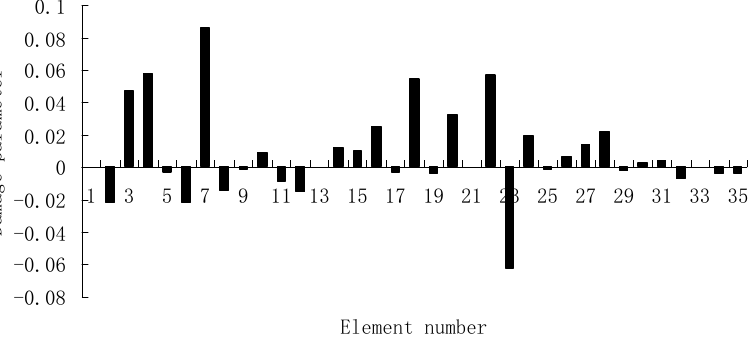
Figure 9. Damage evaluation result by the traditional SVT method for case 2 (elements 7 and 18 had 15% and 20% stiffness reductions).